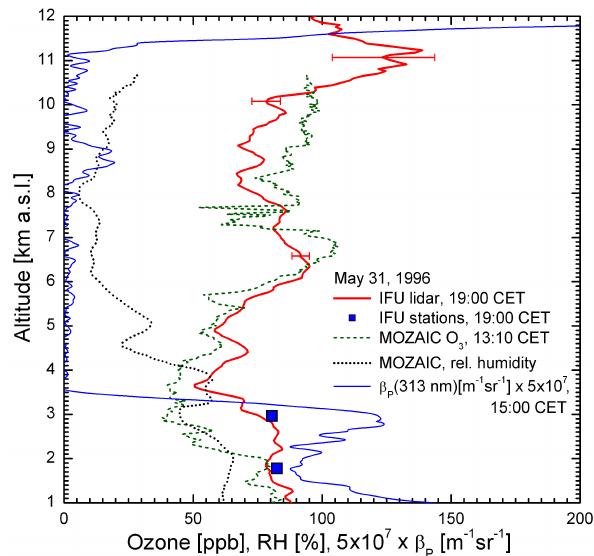
Fig. 1. Ozone mixing ratio and 313-nm aerosol backscatter coeffi- cient β P above IMK-IFU (Garmisch-Partenkirchen) and MOZAIC ozone and relative-humidity (RH) profiles for the departure of a MOZAIC aeroplane rom Frankfurt (Germany); see Fig. 12 in (Trickl et al., 2003). The ozone mixing ratios for the nearby sum- mit stations Wank (1780ma.s.l.) and Zugspitze (2962m) are also given for comparision. The ozone peak at 11km is a temporary fea- ture and somewhat uncertain due to the presence of cirrus clouds just below the tropopause (13.4km ± 0.2km during 31 May). The times are given in Central European Time